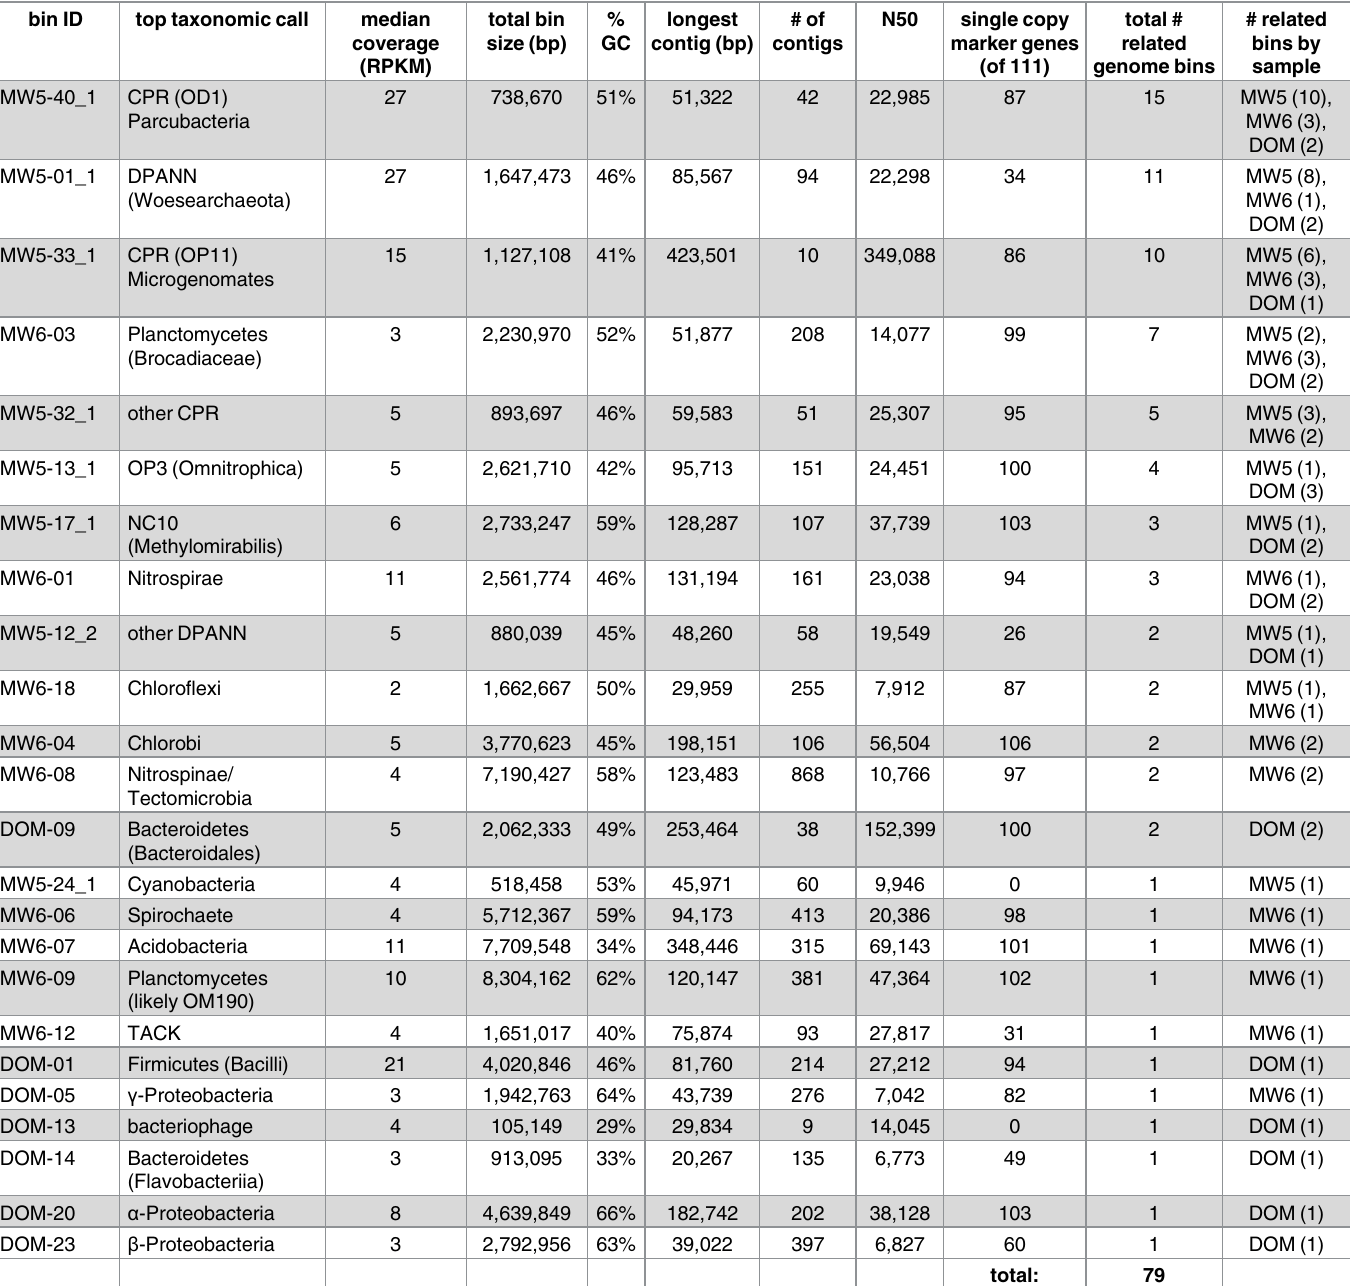
Table 4. Summaryof genomic